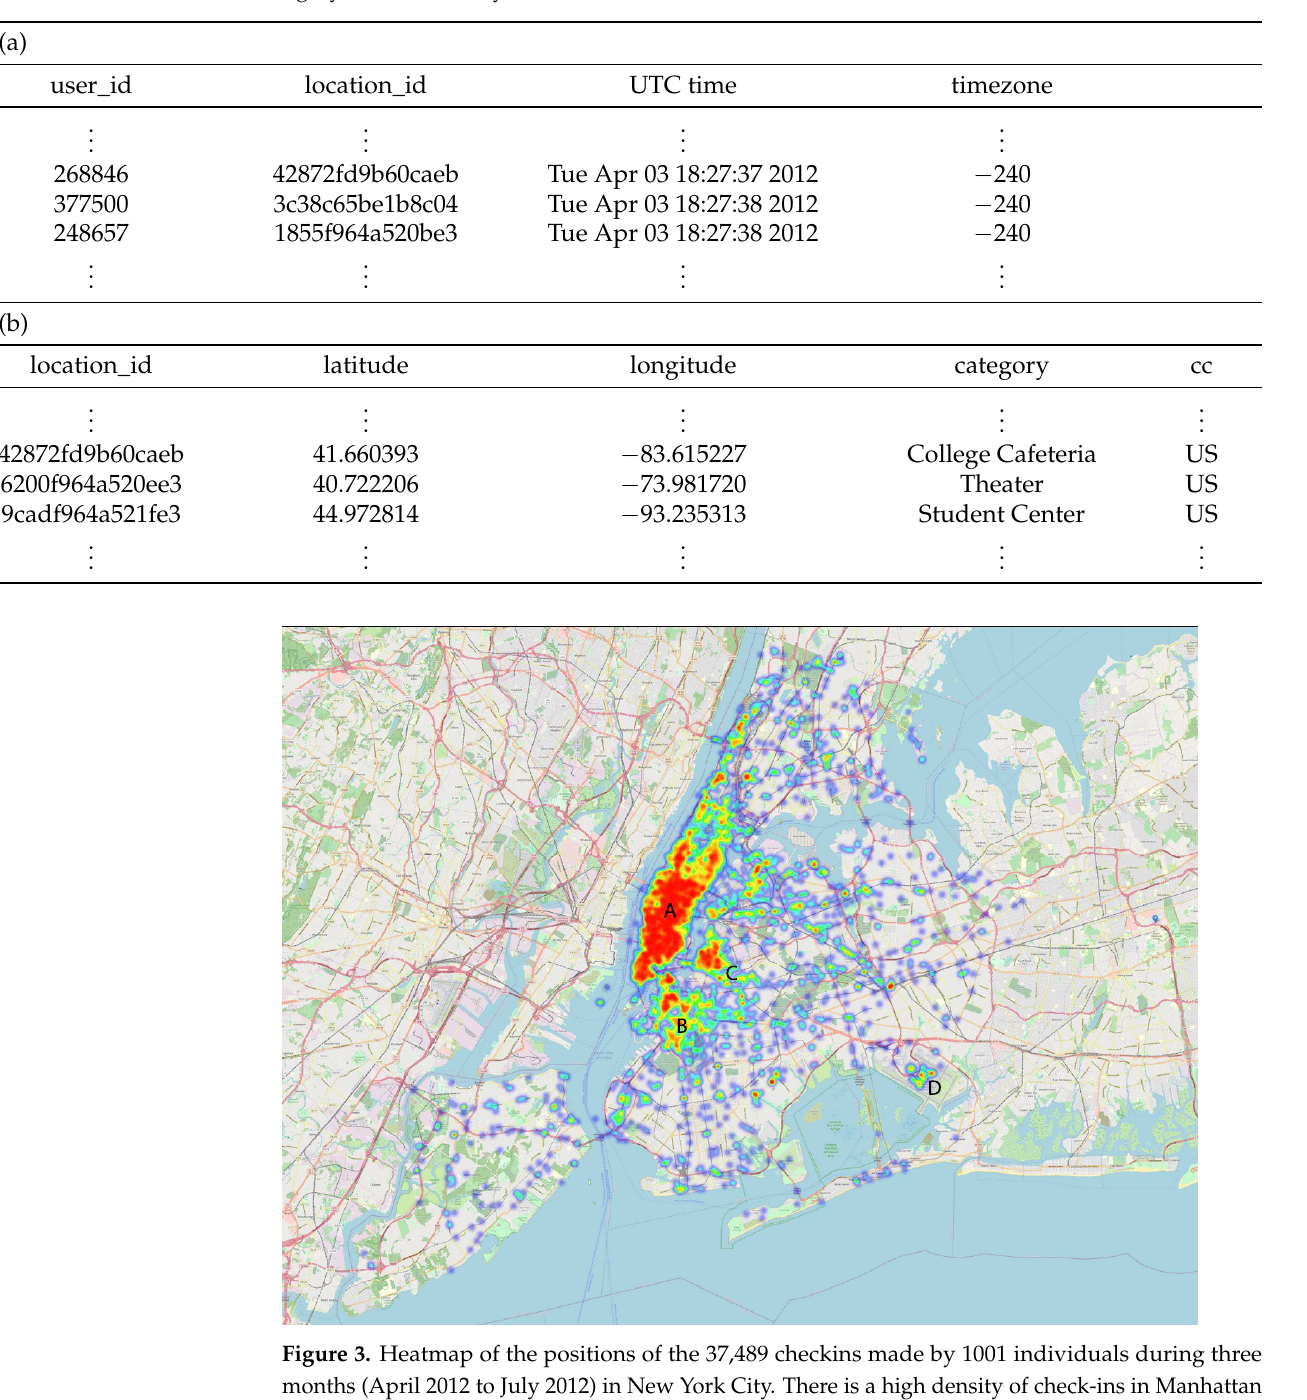
Table 2. An example of records for the dataset D FS (a) and the lookup dataset D loc (b), In D loc the location_id is associated with the coordinates, the category and the country code.